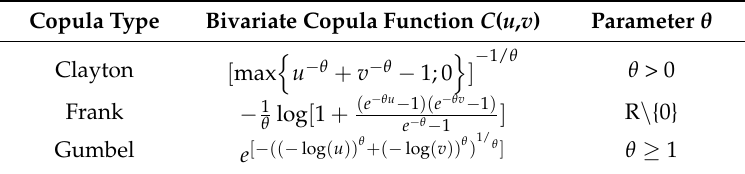
Table 2. Some popular and important